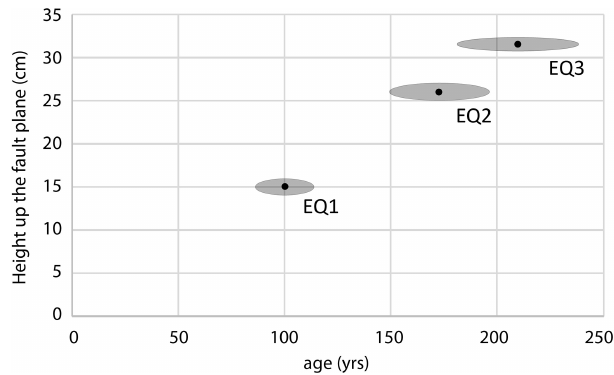
Figure 8. The exhumation history of the free face at site BFS N based on the modeling results (see Fig. 7a and b). The slip rate of 1.7 ± 0.1mmyr − 1 together with the co-seismic amount of offset based on the mapped earthquake horizons results in earthquake ages of 100 ± 14 years (EQ1), 173 ± 24 years (EQ2), and 210 ± 29 years (EQ3). All values are given within the 68% (1 σ ) confidence inter-